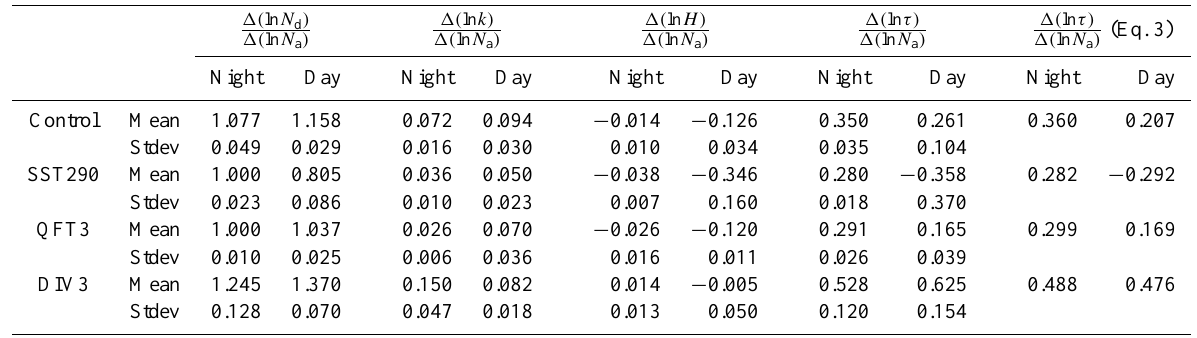
Table 4. Estimation of aerosol-induced effects on MSc cloud properties from the LES model and of cloud susceptibility from Eq. (3) for specific sensitivity simulations under nighttime (4–7h) and daytime (12–15h) conditions; aerosol number concentrations considered are 100, 200, 500, and 1000cm − 3 .